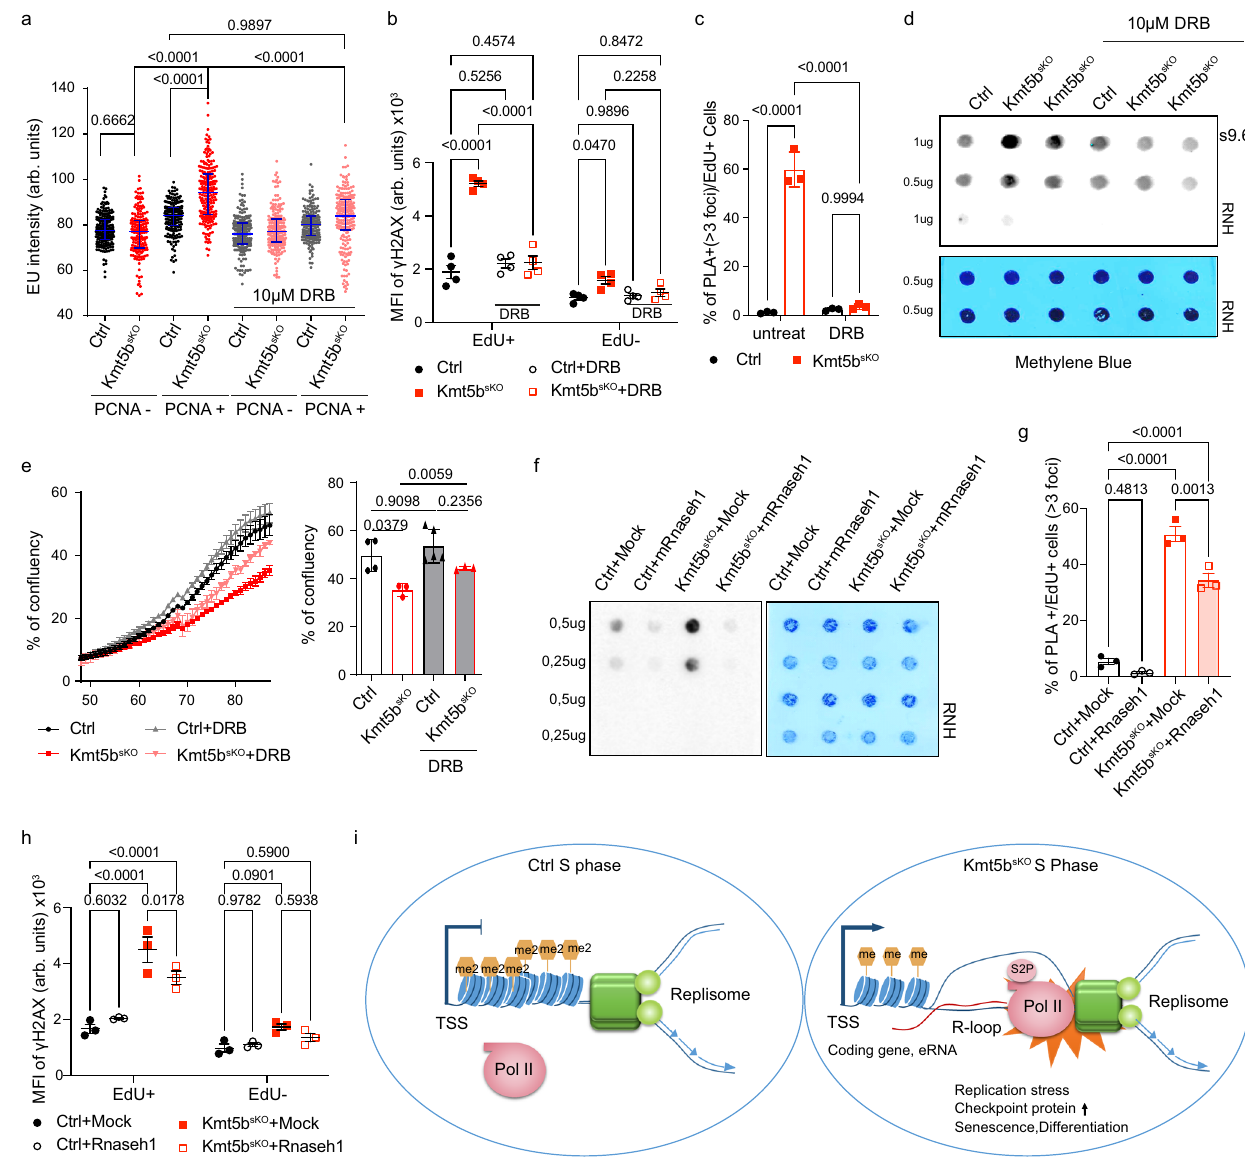
Fig. 5 | Inhibition of S-phase transcription ameliorates TRCs and formation of R-loops. a Quanti fi cation of EU labeling intensity (arbitrary units (arb. units)) in mockandDRB-treated Ctrl and Kmt5b sKO MuSC,eitherinG1-phase(PCNA − )orS-G2- phase (PCNA + ). Error bars represent median±interquartile ranges ( Ctrl PCNA − n =213cells; Kmt5b sKO PCNA − n =182cells; Ctrl PCNA + , n =203cells; Kmt5b sKO PCNA + , n =212 cells; DRB+ Ctrl PCNA − n =213 cells; DRB+ Kmt5b sKO PCNA − n =200 cells; DRB+ Ctrl PCNA + , n =204 cells; DRB+ Kmt5b sKO PCNA + , n =222 cells, over 3 inde- pendent experiments). b Immuno fl uorescence analysis (median of fl uorescence intensity,MFI(arbitraryunits(arb.units))of γ H2AX/EdU + and γ H2AX/EdU − inmock andDRBtreated Ctrl and Kmt5b sKO MuSCs( n =4mice). c Quanti fi cationofEdU + cells with>3PLAfoci(PCNA:PolIIS2P)inmockorDRB-treated Ctrl and Kmt5b sKO MuSCs ( n =3 mice). d Dot-blot analysis of R-loop formation in mock and DRB-treated Ctrl and Kmt5b sKO MuSCs. Genomic DNA treated with RNase H served as negative con- trol and methylene blue staining as loading control ( n =3 mice). e Proliferation curve of mock or DRB treated Ctrl and Kmt5b sKO MuSCs assessed by time lapse